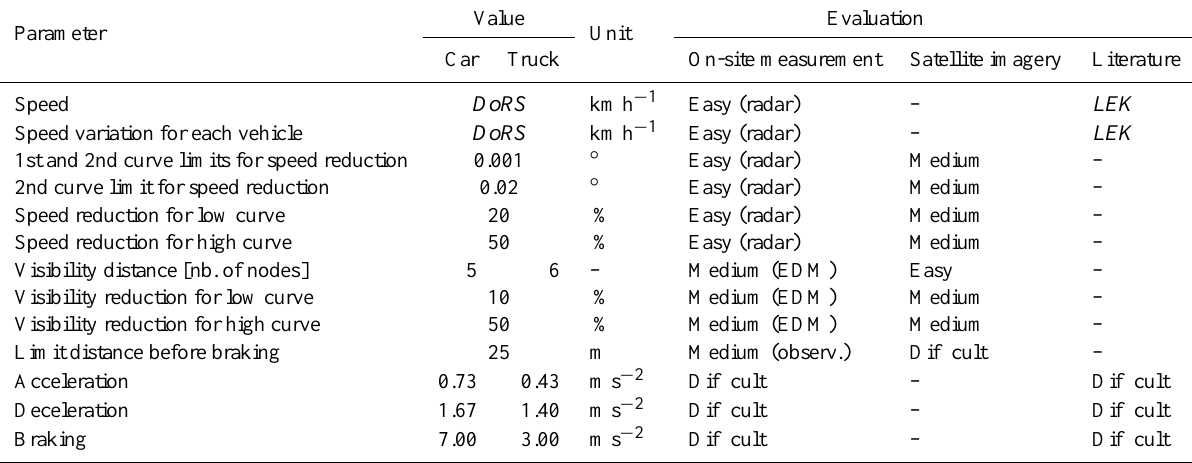
Table 4. Parameter values of speed, visibility and vehicle kinematics of the simulations described in this paper. For each parameter, an evaluation scale is provided with three degrees depending of three types of evaluations methods. The degrees are: easy (fluent to obtain the value), medium (need some time to estimate the value) and difficult (theoretically possible to evaluate the value but almost impossible in reality). The “–” character means that there is no way to obtain a value using the corresponding method. The three methods of evaluations are: (1) on-site measurement (using a measuring device like speed traffic radar or electronic distance measurement [EDM]), (2) imagery (with airphotos, satellite images), and (3) literature (including traffic data from road offices, research literature and local experts knowledge [LEK]). DoRS means depend on road section: different values are given for each section.